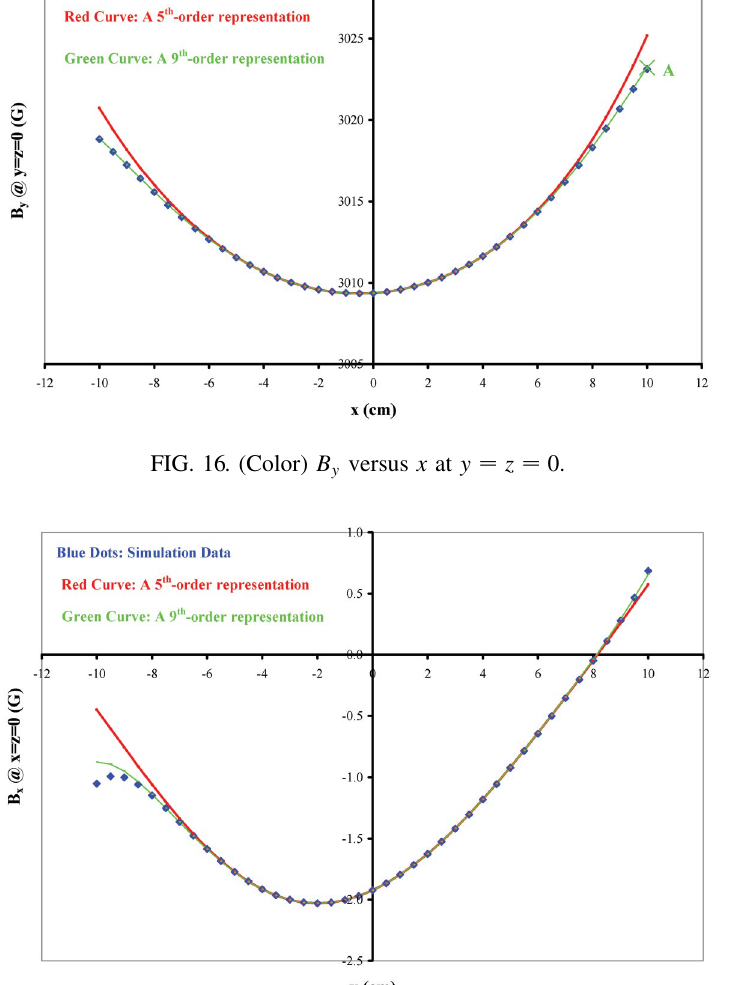
versus y at x (cid:2) z (cid:2) 0 x